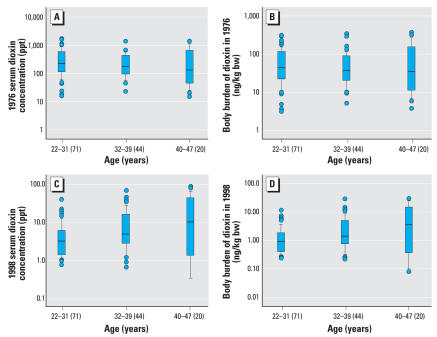
Box plots showing dioxin concentration on a serum lipid basis (A,C) and body burden [ng/kg body weight (bw); B,D] in the same men in 1976 (A, B) and in 1998 (C, D). Values shown are median (line within box), 25th and 75th percentiles (bottom and top of box, respectively), and outliers (circles). Whiskers indicate values within 1.5 times the interquartile range (25th–75th percentiles), and values in parentheses indicate number of men. Serum dioxin concentrations in comparison groups were < 15 ppt in 1976 and < 6.0 ppt in 1998. Because weight was not available in medical records for most of the subjects, dioxin body burden was mostly derived in 1976 using normal percentile distribution of weight according to age.